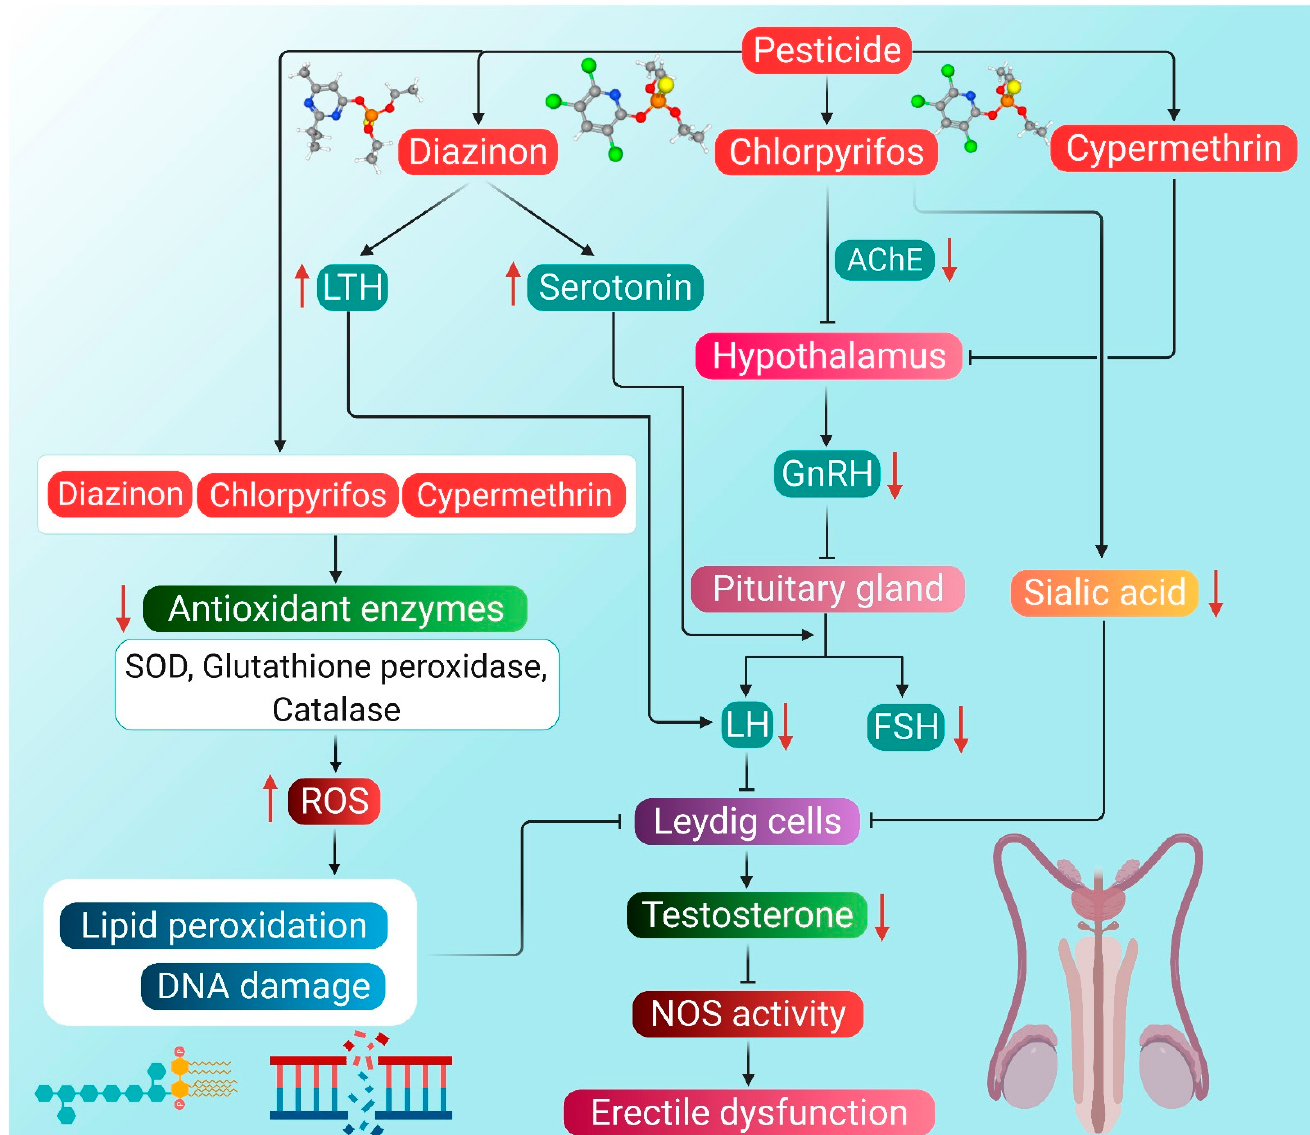
Figure 2. Probable mechanism of association of pesticide-induced ROS with hypogonadism and ED. Diazinon enhances LTH levels, which in turn lowers the activity of LH. Diazinon also stimulates producing serotonin that inhibits the action of both LH and FSH, thereby decreasing testosterone levels. Chlorpyrifos can reduce the activity of AChE in the hypothalamus. Consequently, the entire HPG axis is disrupted, leading to reduced testosterone production. Chlorpyrifos also reduces the concentration of sialic acid, which then inhibits Leydig cells. Cypermethrin disrupts the HPG axis by inhibiting the activity of the hypothalamus. Organophosphorus pesticides diazinon and chlorpyrifos, as well as pyrethroid pesticide cypermethrin, cause a decline in the antioxidant enzyme activity, thereby enhancing ROS generation. ROS causes lipid peroxidation and DNA damage, which inhibits the activity of Leydig cells, followed by reduced testosterone synthesis. Reduction in testosterone levels brings about the inactivity of the NOS enzyme, which ultimately leads to ED. Red arrows represent the increase and decrease of the respective substances, which have a negative impact on testosterone production, leading to hypogonadism and ED. (LTH: luteotropic hormone, AChE: acetylcholinesterase, GnRH: gonadotropin-releas-